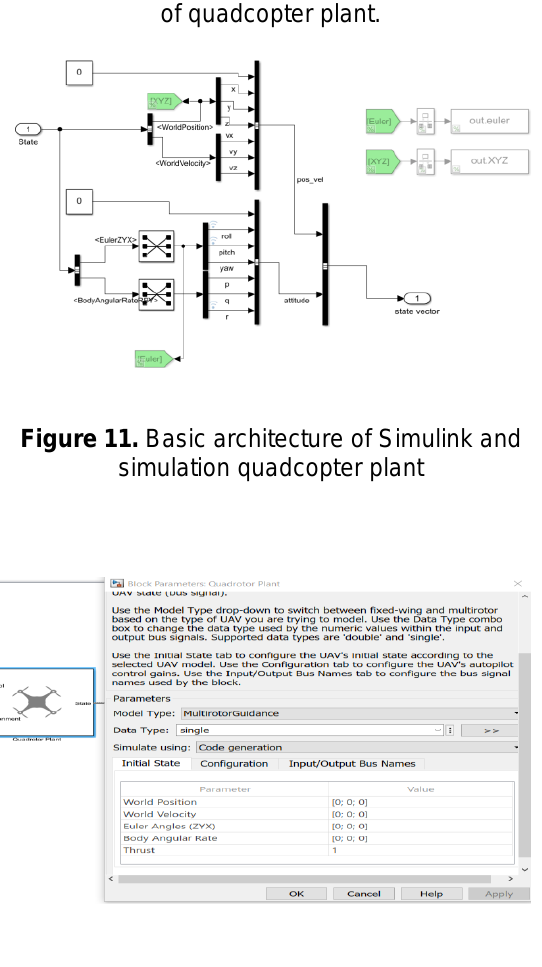
Figure 12. Parameter of quadcopter